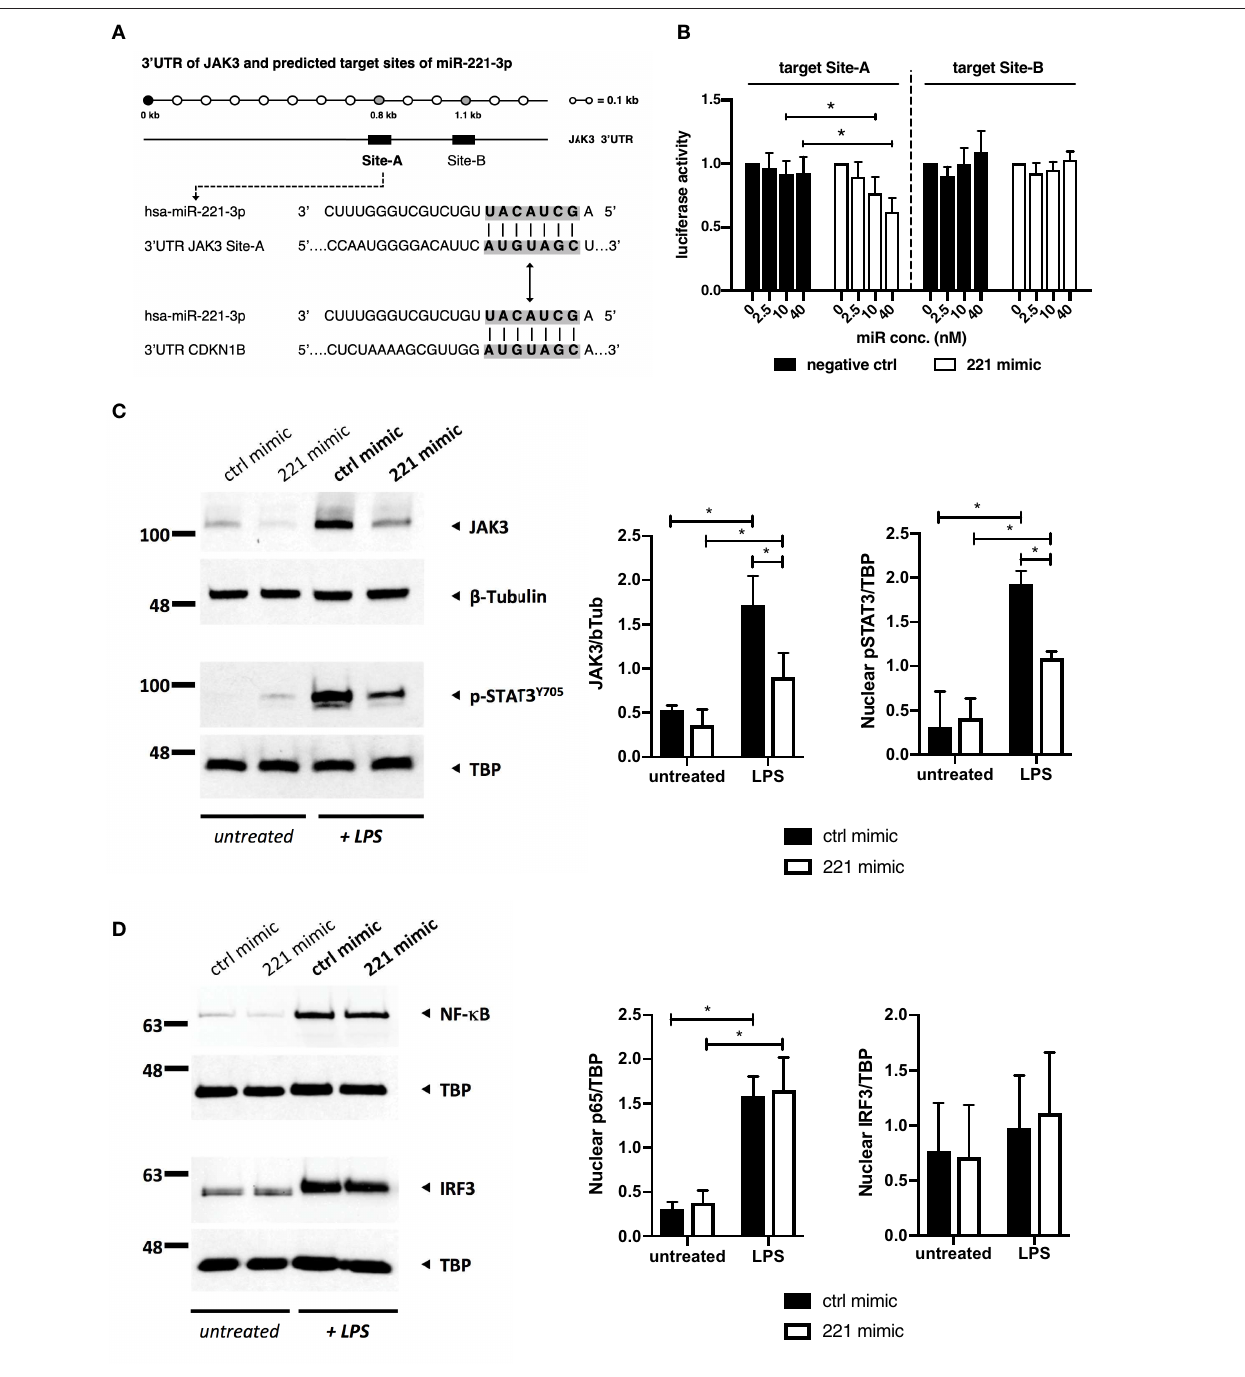
FIGURE 6 | miR-221-3 p is directly interfering with JAK3/STAT3 signaling in TLR4-stimulated M2-macrophages. (A) Location of two predicted miR-221-3 p targets, Site-A and Site-B, within the 3’UTR region of the human JAK3 mRNA. Sequence of Site-A contains seed match region identical to already established miR-221-3 p target on CDKN1B gene (gray shading). (B) Luciferase reporter assay of constructs carrying JAK3 Site-A and JAK3 Site-B target sites, co-transfected with increasing concentration of miR-221-3 p (221 mimic) or RNA duplex carrying randomized base pairs (negative ctrl). Luciferase activity represents Renilla/firefly values normalized 0nM and is expressed as mean ± S.D. N = 3–8, * p < 0.05. Differentiated M2-macrophages derived from CD14 + cells of HD blood were transfected with miR-221-3 p mimic (221 mimic) or a respective control miR (ctrl mimic) and stimulated with 100ng/ml LPS for (C) 16h and (D) 1h or left untreated. Protein levels of (C) JAK3 and phosphorylated STAT3 and nuclear shuttling of (D) p 65 (NF- κ B) and IRF3 were analyzed by SDS-PAGE and visualized by immunoblotting. TBP and β -Tubulin were used as loading controls for nuclear protein extract or whole cell lysates, respectively. Shown are representative images and quantification of N = 3–5. Quantification of protein expression was measured using ImageJ software and represented as a relative density ratio (protein of interest to loading control). Values are expressed as mean ± S.D. N = 3–5, * p < 0.05.